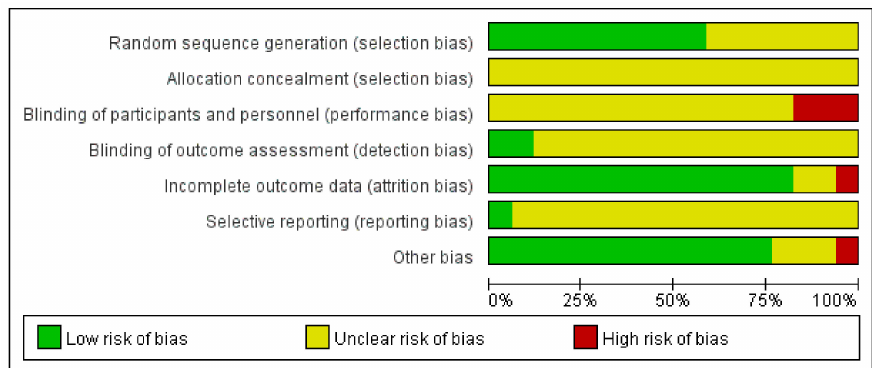
Figure 3. Risk of bias graph for all included